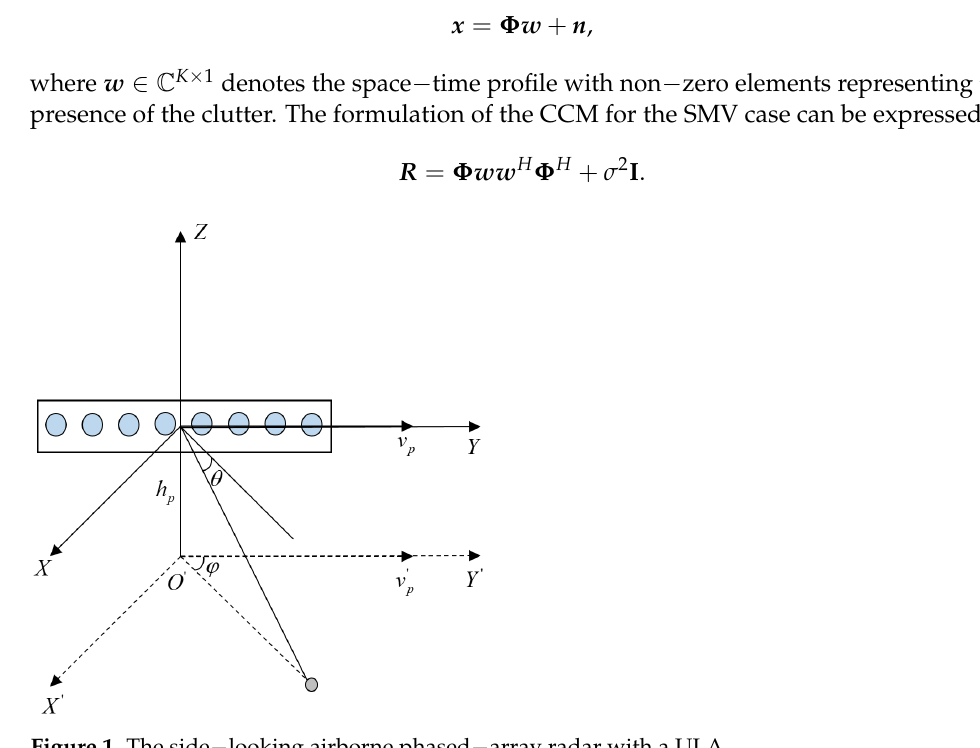
Figure 1. The side − looking airborne phased − array radar with a